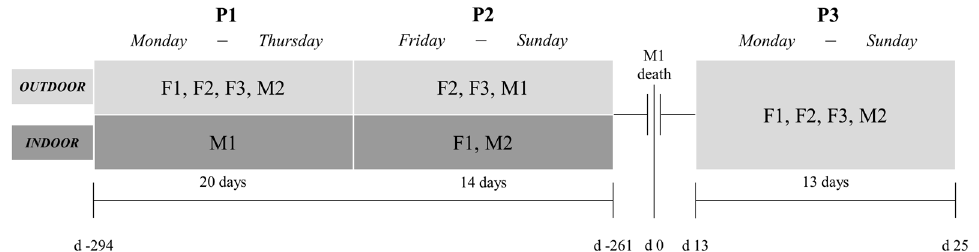
Figure 1. Experimental design of the study. Before the death of M1, weekly management, including two phases ( P1 and P2 ), was carried out to avoid cohabitation conflicts between M1 and M2. After the death of M1, these management dynamics were ceased ( P3 ). A total of 20 days were sampled for P1, 14 days for P2, and 13 days for P3. Days from the death of M1 are indicated for each phase. Abbreviations: F1, female 1; F2, female 2; F3, female 3; M1, male 1; M2, male 2.